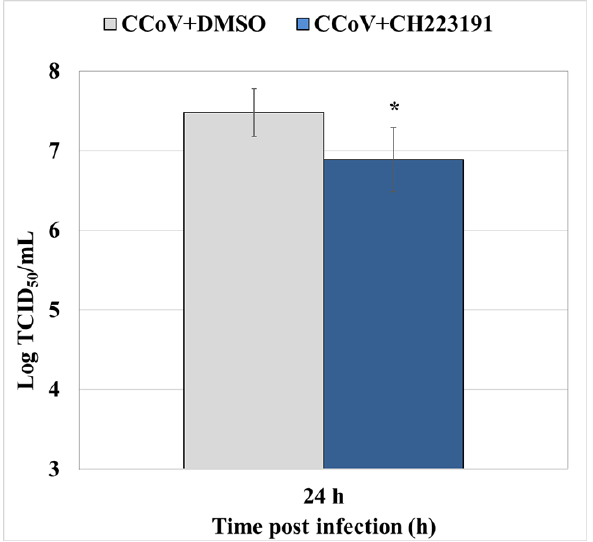
Figure 7. AhR inhibitor decreases virus yield during CCoV infection in A72 cells. Cells were infected with CCoV in the presence or absence of AhR inhibitor CH223191. At 24 h p.i., virus yield was evaluated by RT-qPCR by the mean of a standard curve created plotting Log TCID 50 /mL against the C t number. Significant differences between CCoV-infected cells and AhR-inhibitor-treated infected cells are indicated by probability p . * p < 0.05.